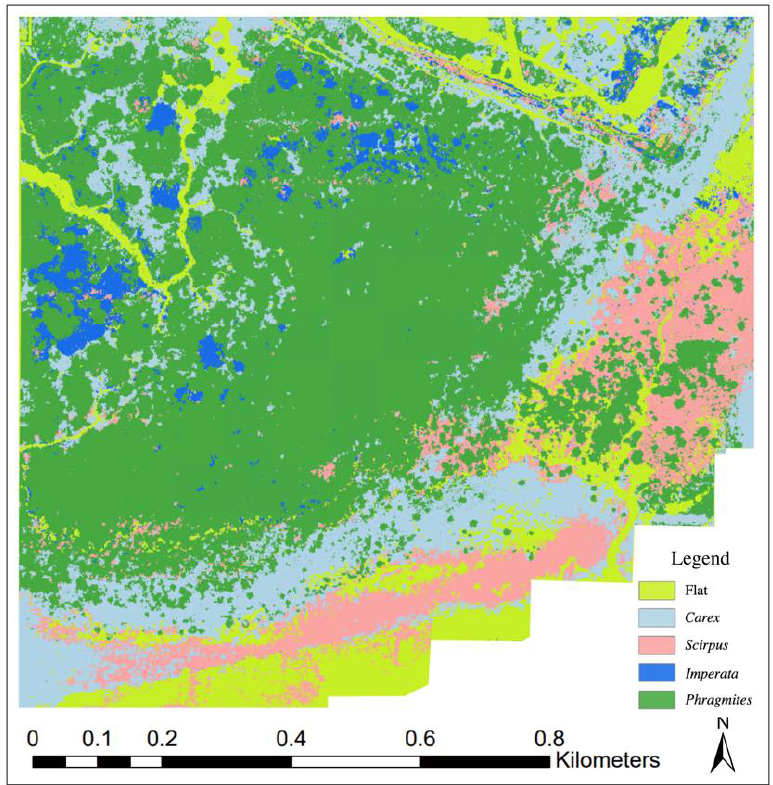
Figure A2. Thematic map of OBIA classification in the study area, in which all features (RGB + VI + Texture + DSM) are used.